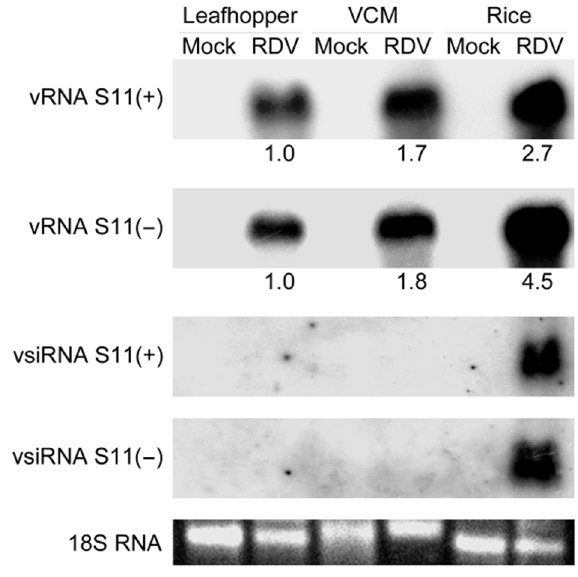
Figure 1. Accumulation of RDV genomic RNA S11 and vsiRNAs in different hosts. Northern blot assay of RDV genomic RNA and vsiRNAs in leafhoppers, vector cells in monolayer (VCMs), and rice. The 18S RNA served as a loading control. Mock—non-viruliferous insects or plants; RDV—viruliferous hosts; ( + )—positive-strand RNA; ( − )—negative-strand RNA; vRNA—RDV genomic RNA. Gel blot signals were quantified, and the relative intensities are shown below each